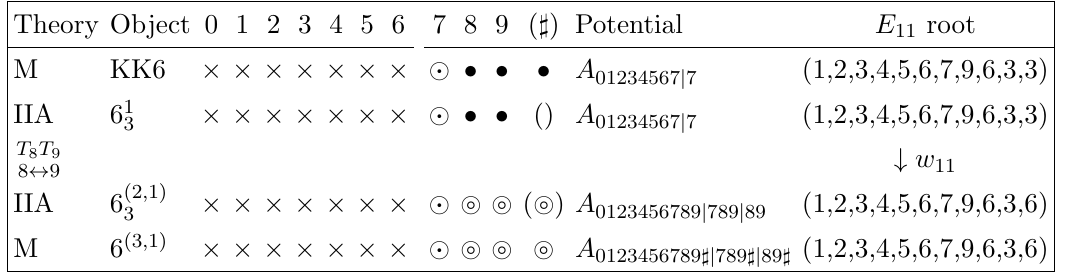
Table 7 . Traditional SL(5) U-duality orbit of a smeared KK6 monopole to a 6 (3 ; 1) -brane with corresponding potentials and E 11 roots. The (cid:15) indicates non-compact directions on which the full KK6 monopole depends, these are smeared in the traditional procedure. The (cid:12) and } denote directions that appear quadratically and cubically in the BPS mass formula respectively. (cid:2) are world-volume